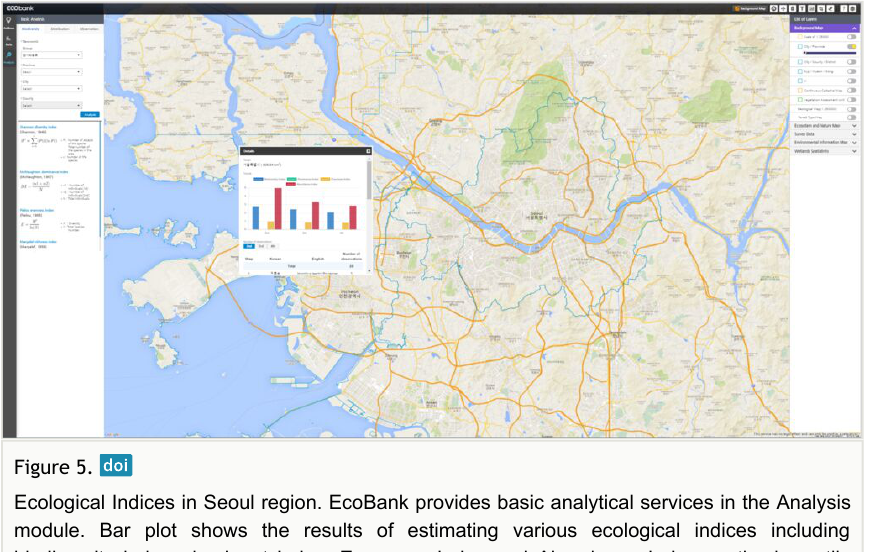
module. Bar plot shows the results of estimating various ecological indices including biodiversity index, dominant index, Evenness Index and Abundance Index on the herpetile species in the Seoul